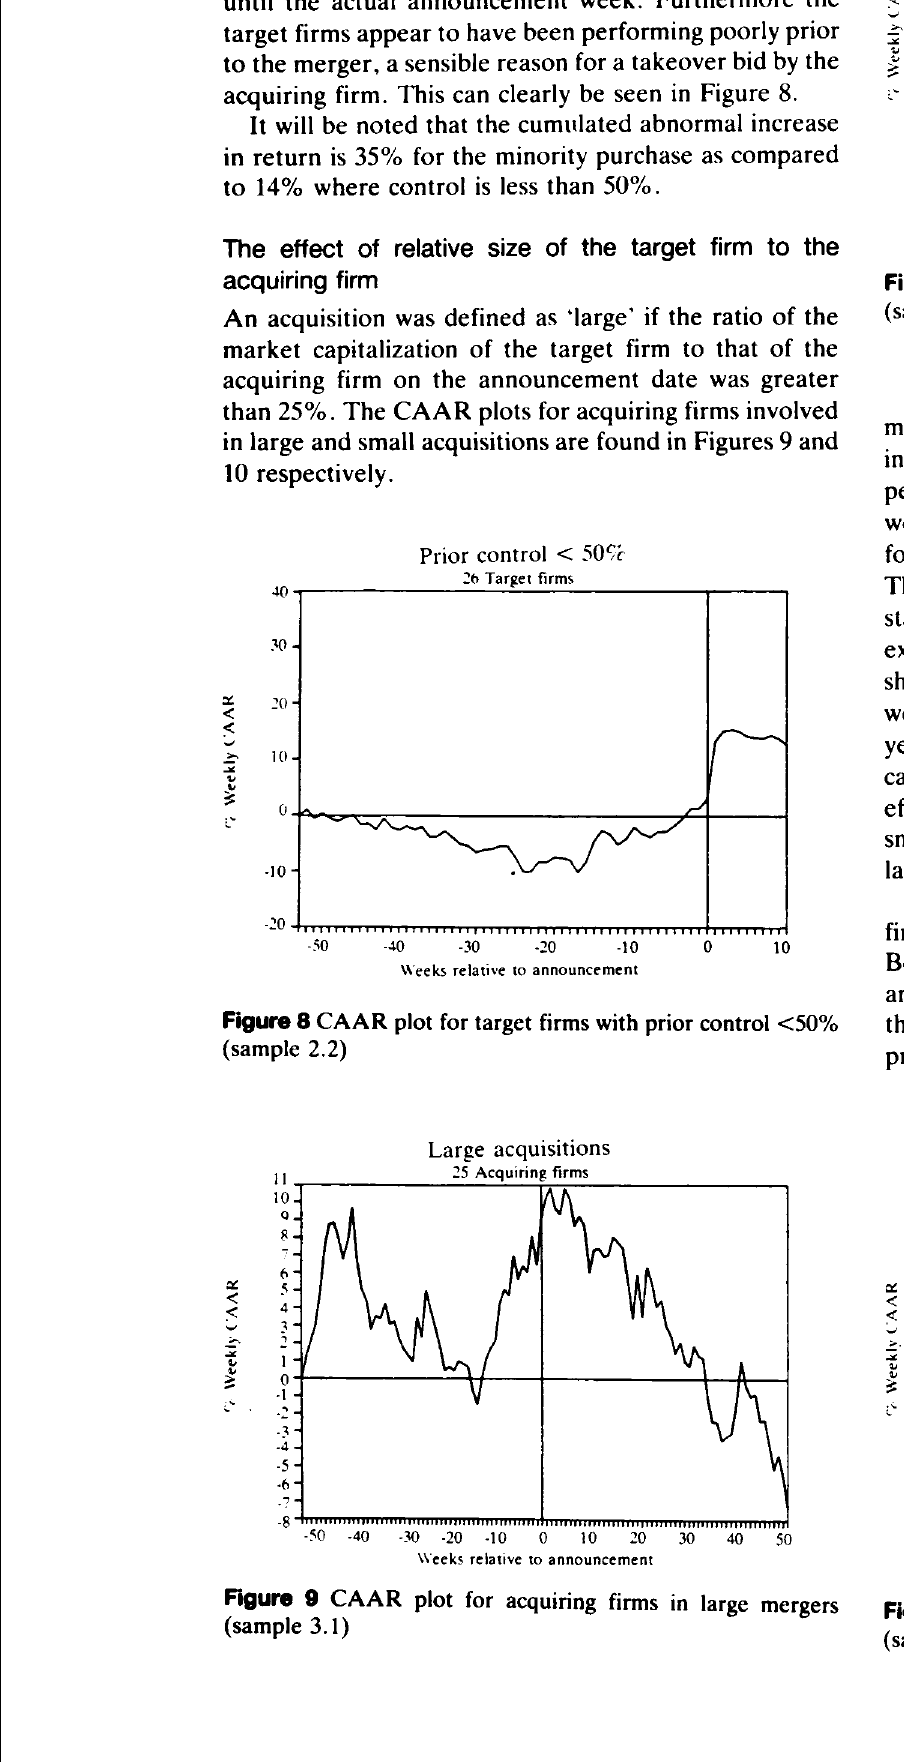
Figure 11 CAAR plot for target firms in small mergers (sample